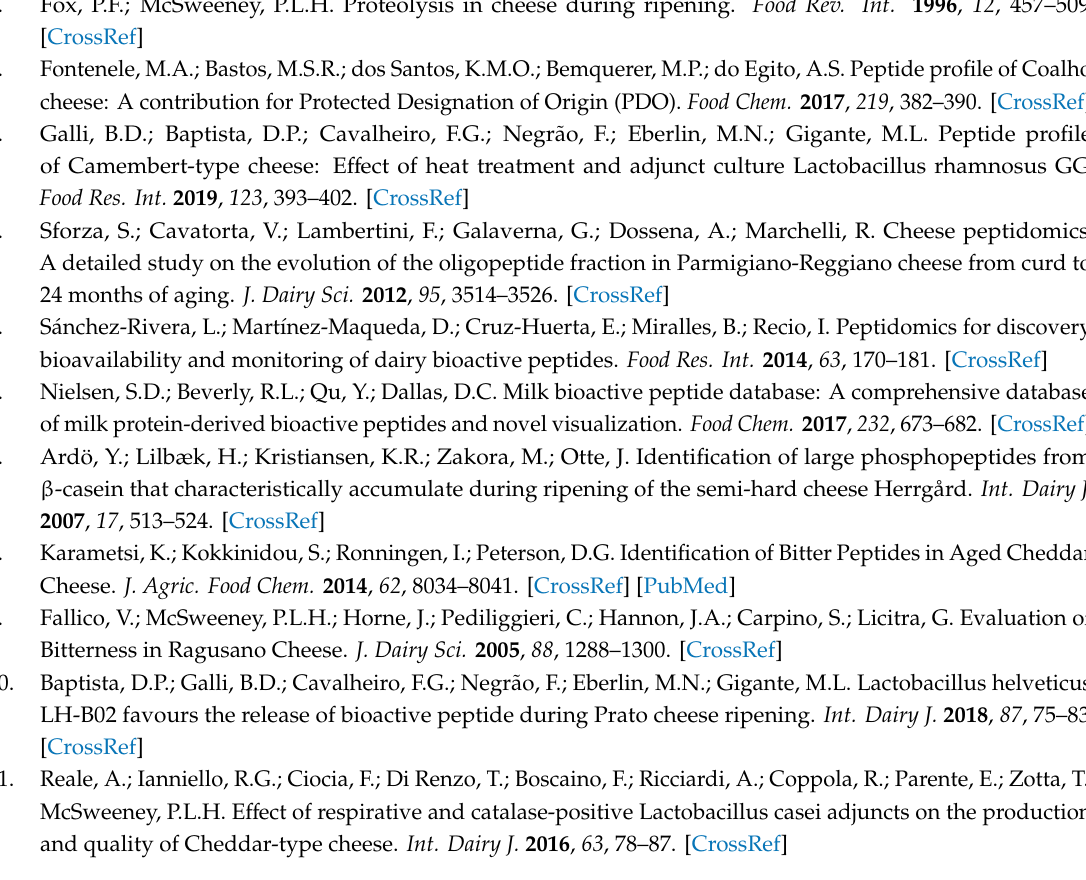
Figure S1: Summed peptide intensities of Cheese 1, 2 and 3 at the day 90, Figure S2: Peptide length distribution across 3 cheeses at the day 90, Figure S3: Overlay of Base Peak Intensity and Extracted Ion Chromatogram for narrowest peak corresponding to an identified